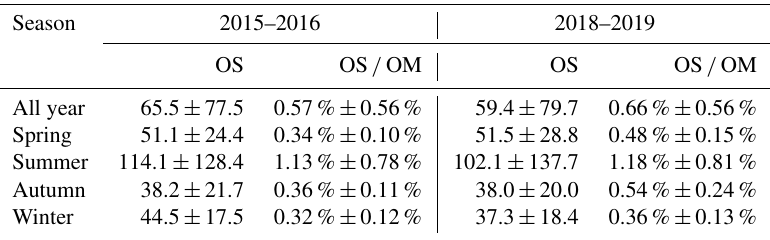
Figure 2. Time series of temperature, relative humidity (RH), wind speed, O 3 , NO 2 , SO 2 , aerosol liquid water content (ALWC) and liquid [H + ]; concentrations of particulate organic matter (OM), elemental carbon (EC), sulfate, nitrate, chloride, ammonium; and the abundance of OSs and their contribution to OM in 2015–2016 and 2018–2019 in Shanghai. Table 2. A summary of OS concentrations (inngm − 3 ) and their contribution to OM (OS / OM) in the four seasons in 2015–2016 and